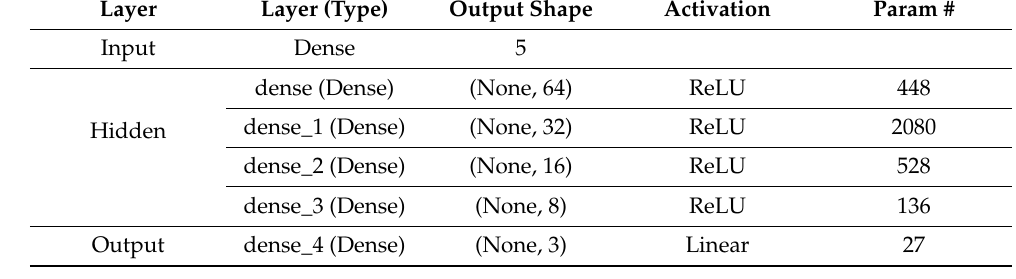
Table 7. Network architecture of TIG and SMAW welding processes.